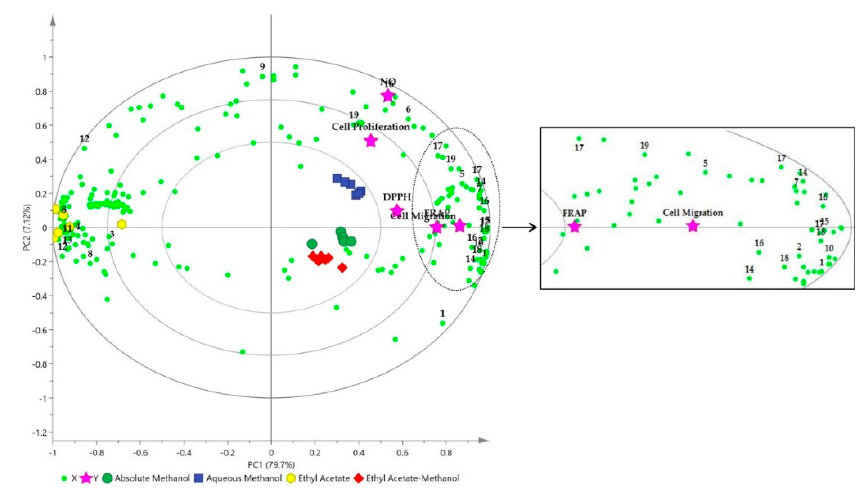
Figure 5. Partial least square (PLS) loading biplot of bioactivities represented by ferric reducing antioxidant power (FRAP), 2,2-diphenyl-1-picrylhydrazyl (DPPH), and nitric oxide (NO) free radical scavenging activities, cell proliferation, and cell migration. Identified metabolites: 1 , sucrose; 2 , fructose; 3 , α -glucose; 4 , β -glucose; 5 , choline; 6 , citric acid; 7 , fumaric acid; 8 , palmitic acid; 9 , succinic acid; 10 , aconitic acid; 11 , fatty acid; 12 , α -linolenic acid; 13 , acetic acid; 14 , ( − )-epicatechin; 15 , ( + )-catechin; 16 , orientin; 17 , isoorientin; 18 , vitexin; 19 , isovitexin.